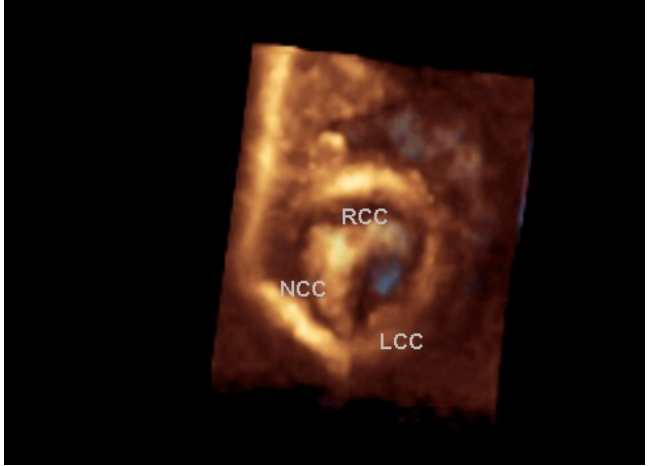
Figure 1. Valvular aortic stenosis with a bicuspid valve. A full volume rendered three-dimensional echocardiographic “surgeon’s view” of a bicuspid aortic valve in systole showing fused right (RCC) and noncoronary (NCC) cusps with prominent ridge, a smaller left coronary cusp (LCC) (lower to the orifice) and an eccentric elliptical restricted ori fi ce (in light blue color).